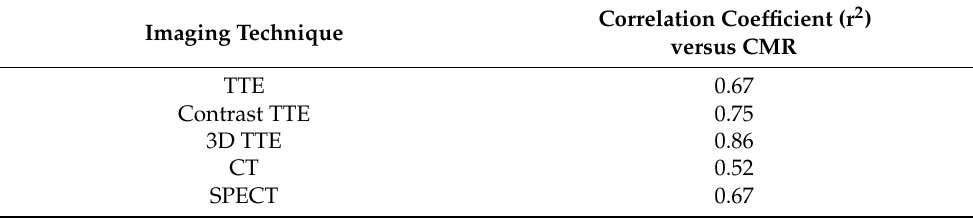
Table 3. Correlation coefficients between different imaging modalities for the evaluation of left ven- tricular ejection fraction, using CMR as the reference standard. TTE = transthoracic echocardiography, CMR = cardiac magnetic resonance, CT = computed tomography, SPECT = single photon emission computed